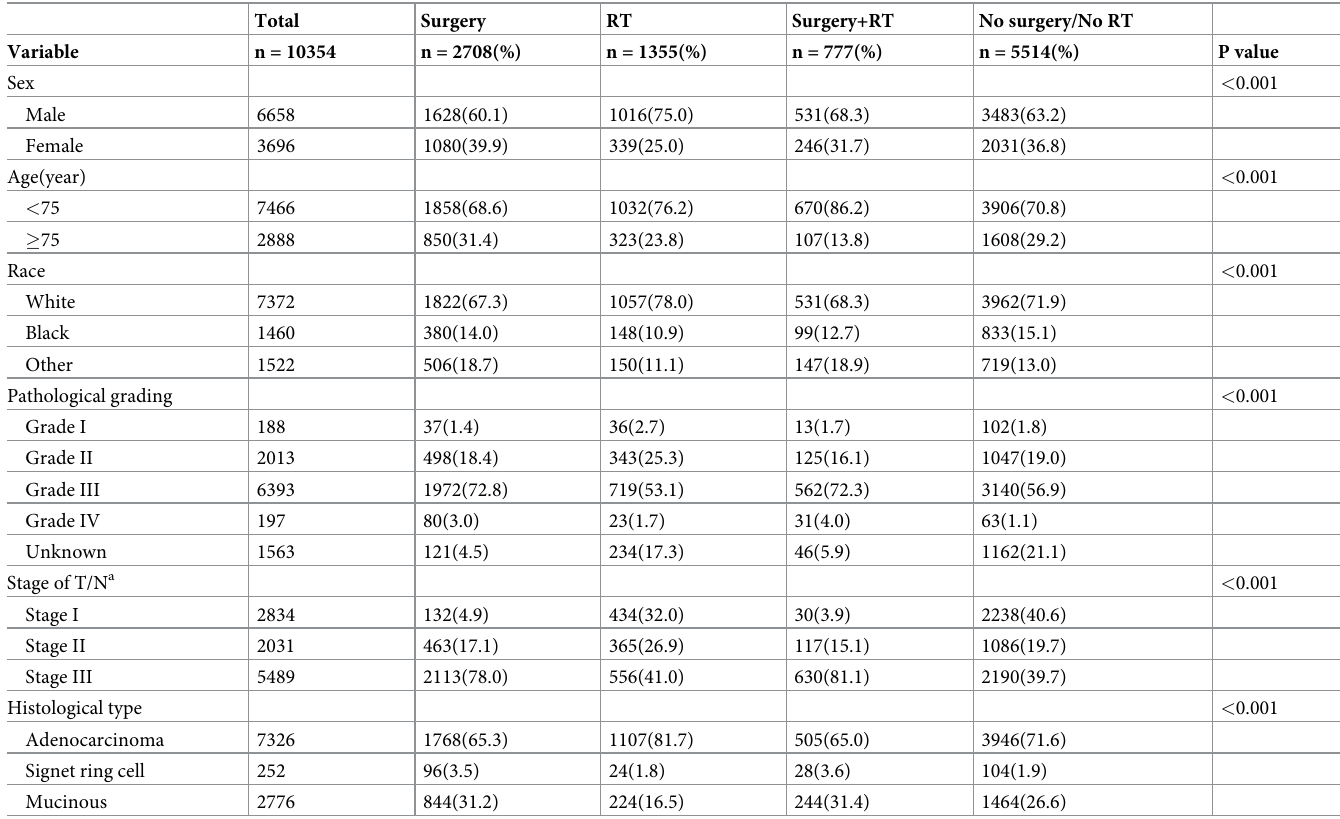
Table 1. Patient